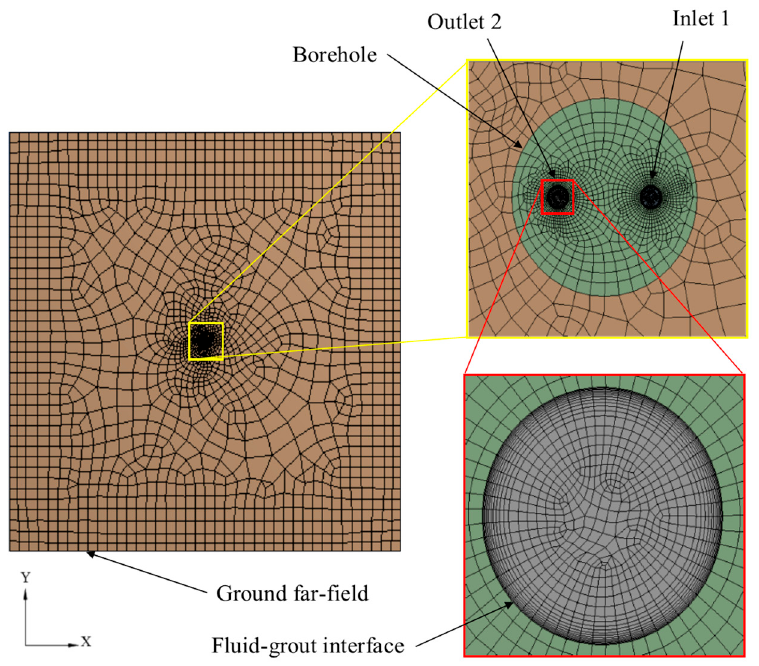
Figure 3. Top view of the three-dimensional (3D) mesh with enlargements.